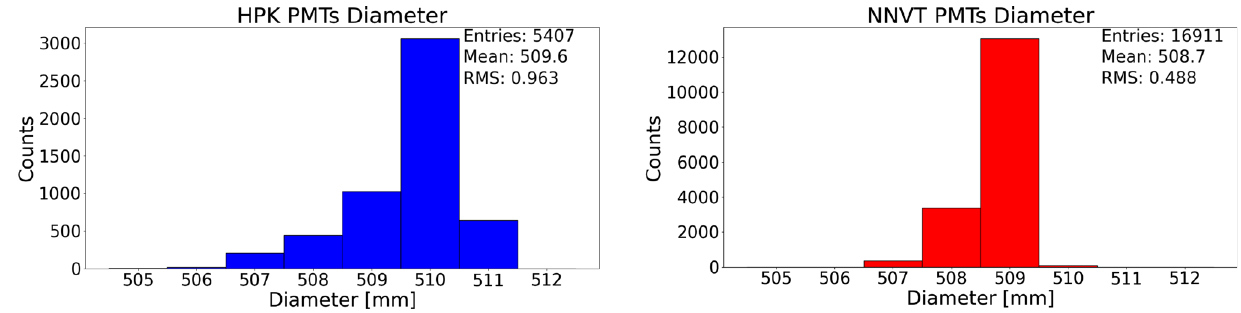
Fig. 8 Measureddiameterinmmofallchecked20-inchPMTs.SomePMTswererejectedbeforethemeasurementaftervisualinspection,therefore the total number of tested PMTs is slightly reduced. Left: HPK; Right: NNVT